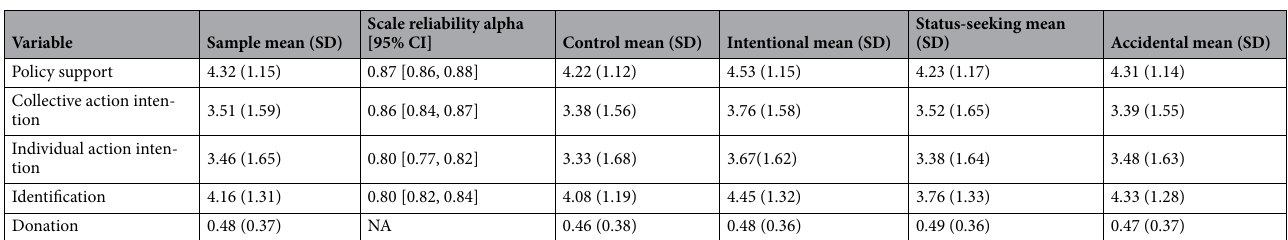
Table 1. Descriptive statistics of dependent variables (sample and